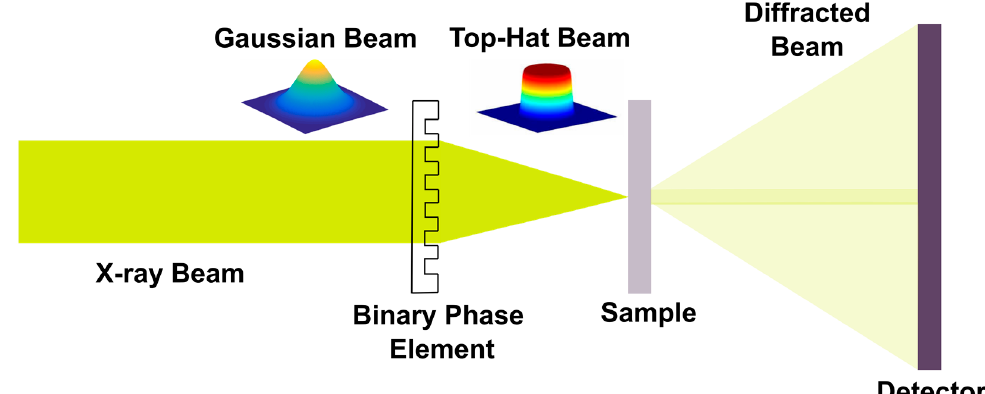
Figure 1. Schematic for the proposed coherent X-ray diffraction imaging with uniform illumination.